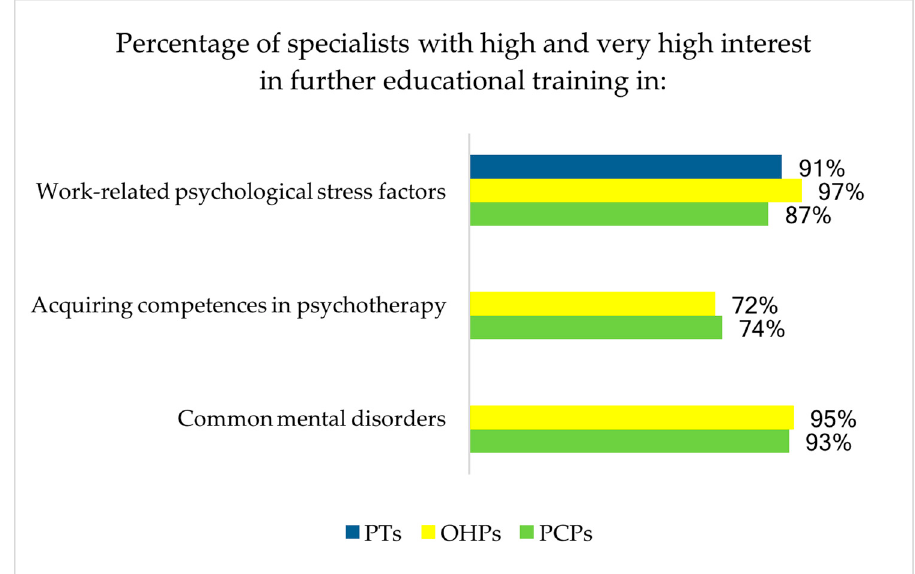
Figure 3. Need for further educational training (FET) for each profession. Range of answers from